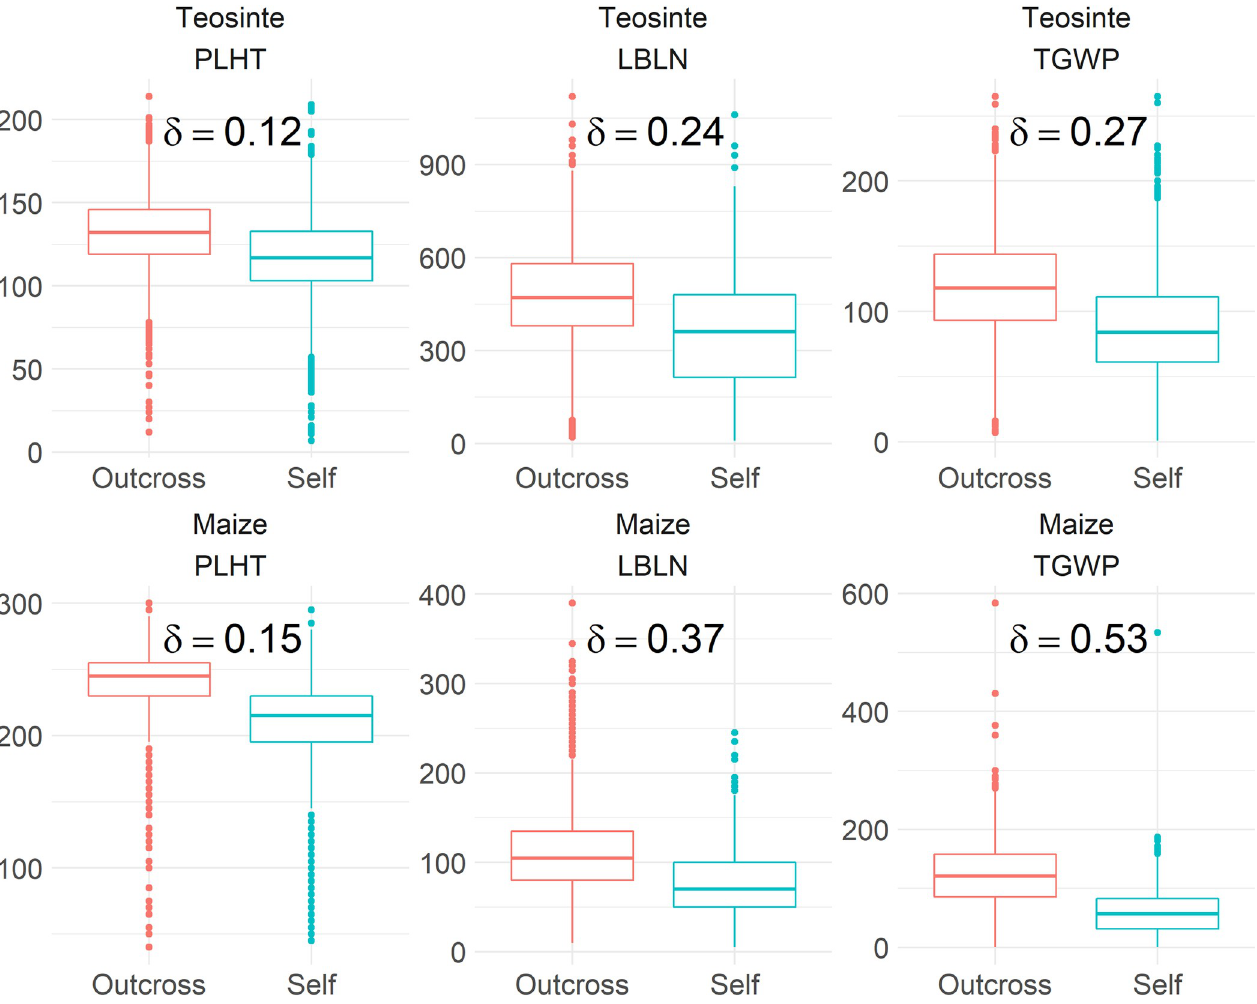
Fig 2. Distribution of representative traits plant height (PLHT, a Vegetative/Flowering Time trait), lateral branch length (LBLN, an Environmental Response trait), and total grain weight per plant (TGWP, a Reproductive trait) among outcross and selfed progenies in teosinte and maize. The coefficient of inbreeding ( δ ) represents inbreeding depression as the mean proportional decline in trait values due to one generation of